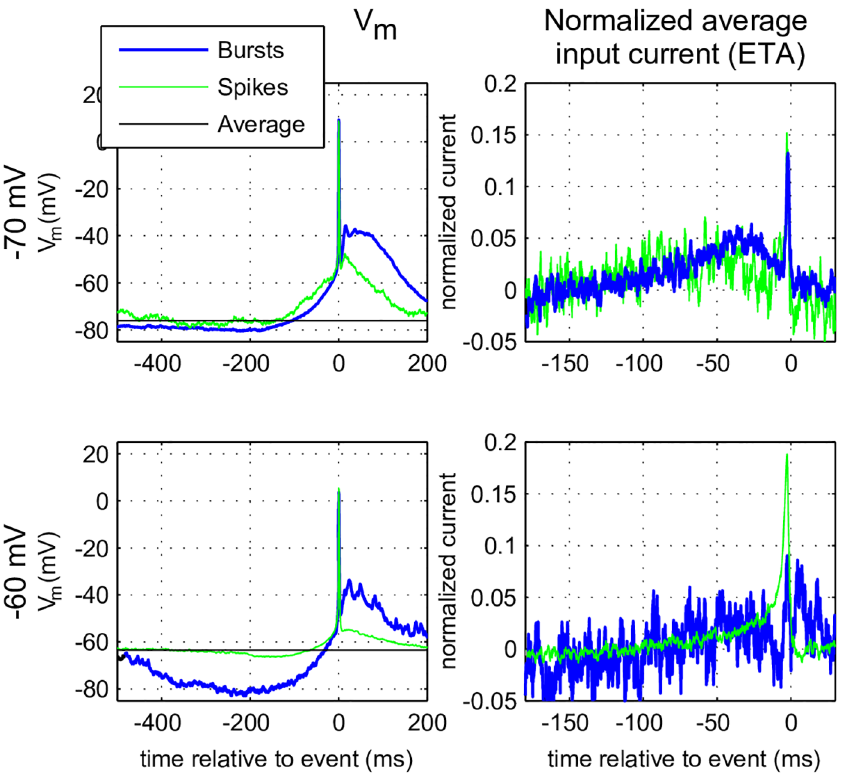
Fig 7. Event Triggering Average (ETA), using a fast-fluctuating input current. Repeat of the experiment in Fig 6 but now with the input filter ( τ = 1 ms) and only for mixed membrane states at − 70 mV (top row) and − 60 mV (bottom row) as only they produced sufficient spikes and bursts for the analysis. Left column: ETA of the membrane potential 500 ms preceeding single spikes (green) or bursts (blue). Right column: ETA over the input current (mean value substracted and normalized with the L2 norm). The horizontal black line indicates the mean value of the subthreshold membrane potential calculated from the entire trial. Other details as in Fig